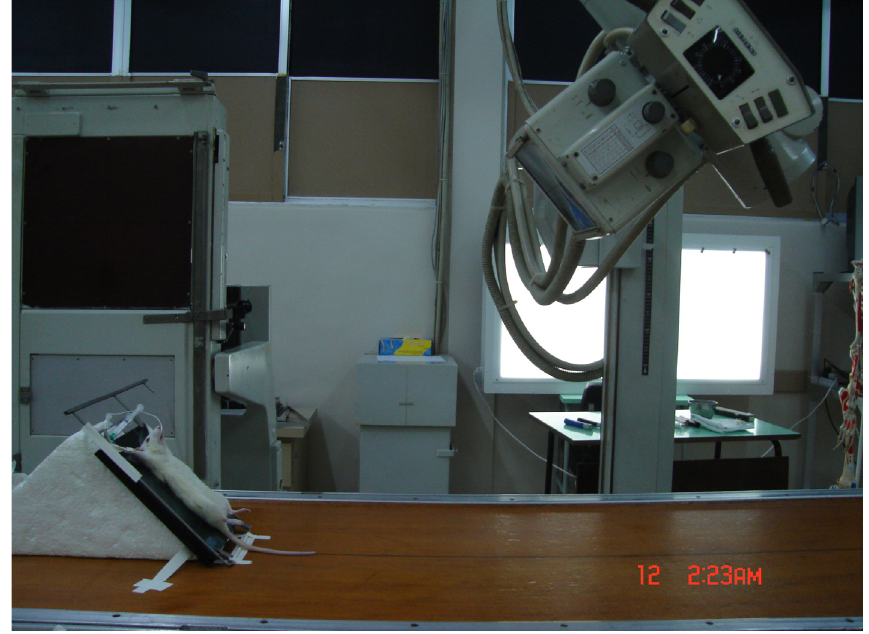
FIGURE 1 - Position of the specimens on the radiological table